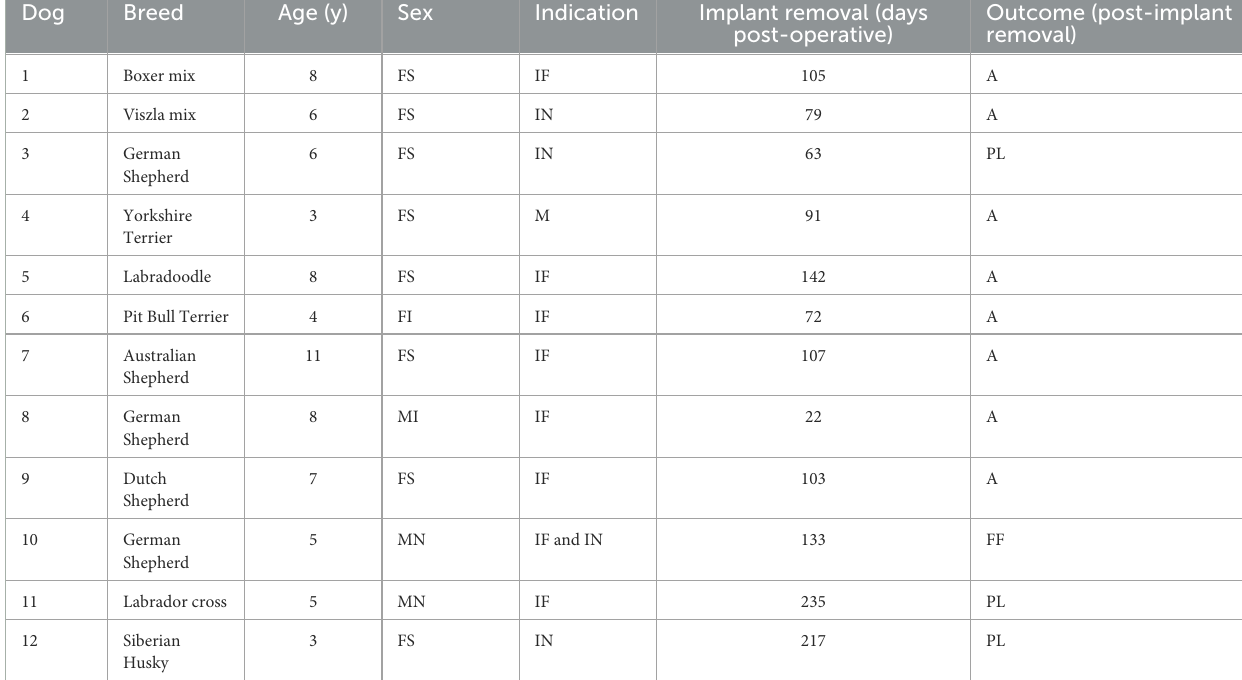
TABLE 1 Case details of implant removals in 12 dogs.